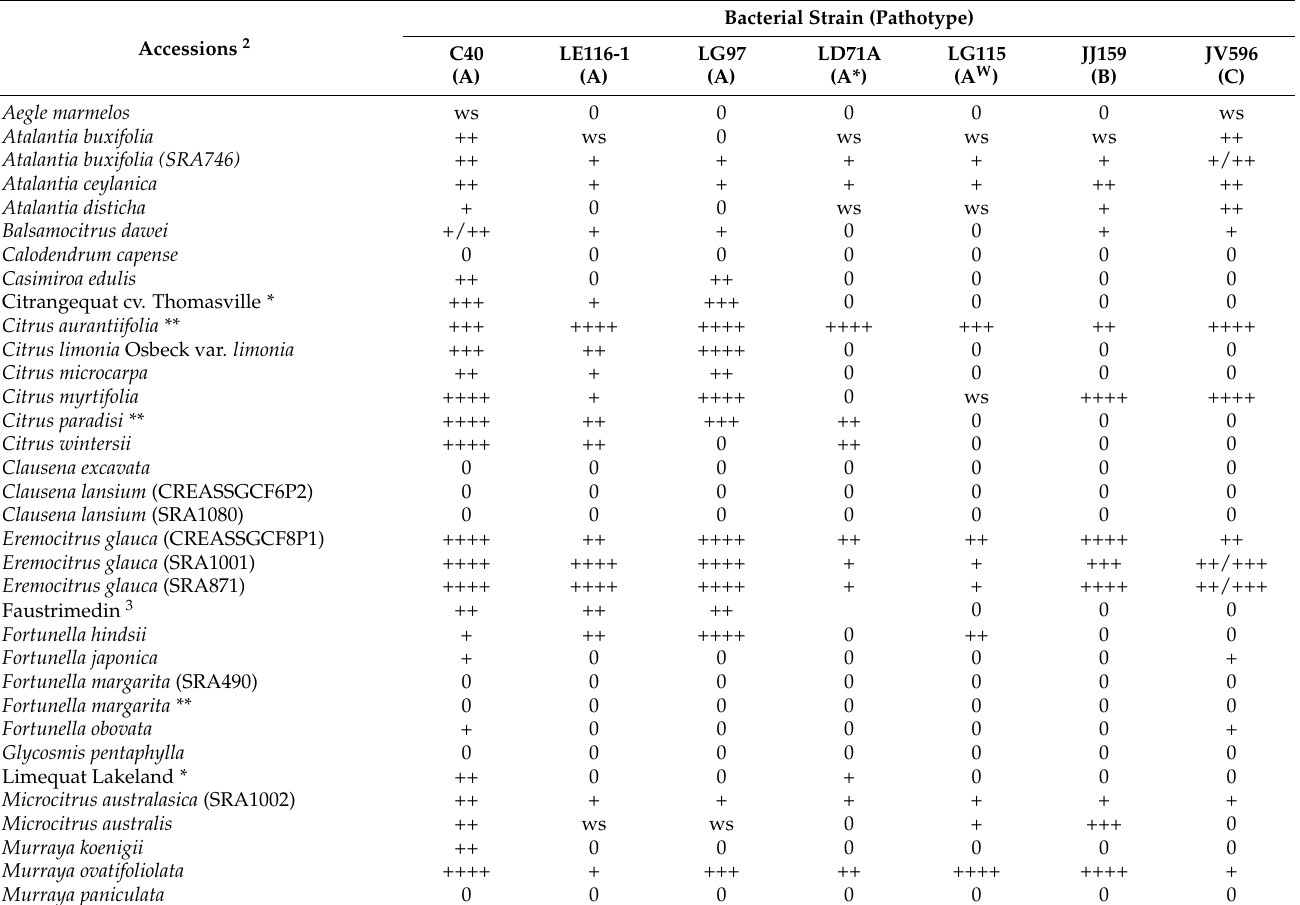
Table 3. Interaction phenotype between ornamental species of Rutaceae species and reference plants with bacterial strains Xanthomonas citri pv. citri and pv. aurantifolii 1